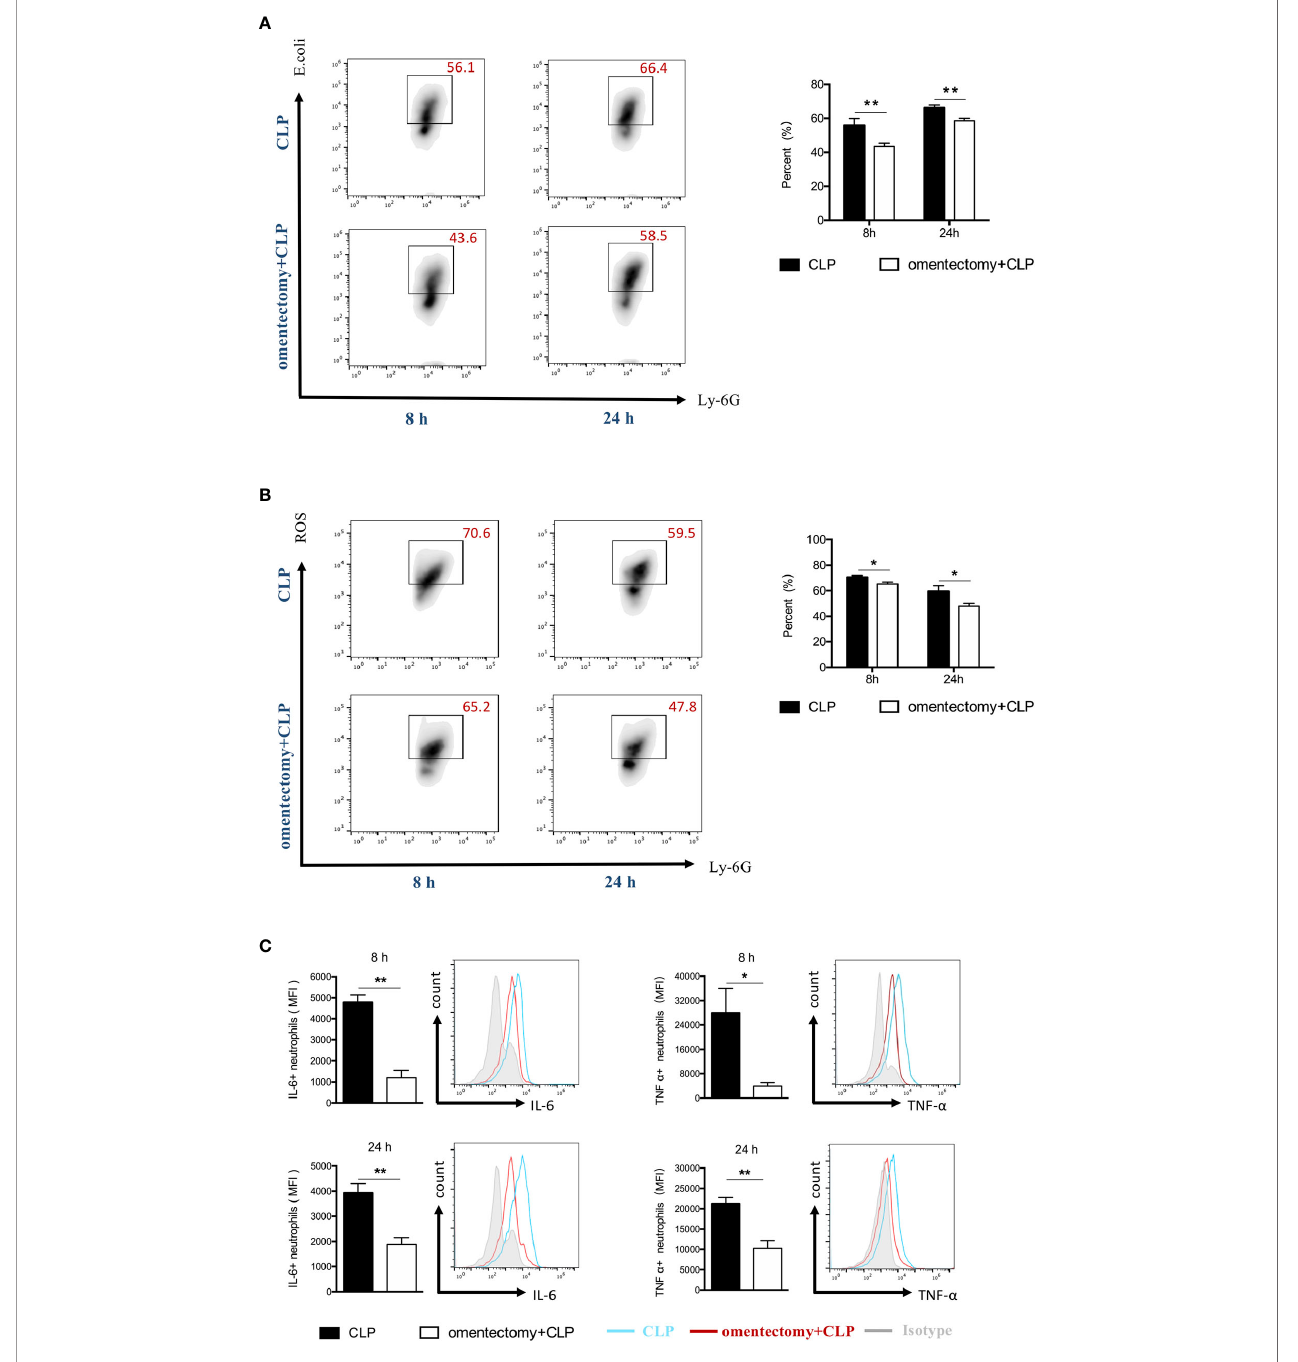
FIGURE 5 | The omentum regulates the functional activity of peritoneal neutrophils during CLP -induced peritonitis. At indicated intervals, peritoneal cells were collected from WT and omentectomized mice (n = 6 per group). Cells were stained for neutrophil markers (Ly6G + CD11b + ) and assessed for phagocytic capacity (A) or ROS production (B) as described in Materials and Methods. Cells were stained for neutrophil surface markers (Ly6G + CD11b + ) and intracellular cytokine antibodies for TNF- a or IL-6 (C) . The bar graph represents the average mean fl uorescence intensity (MFI) of TNF- a and IL-6 in neutrophils. Data are representative of three independent experiments with similar results, and data in the bar graph are shown as means ± SEM. ** p < 0.01 and * p < 0.05 for omentectomized vs